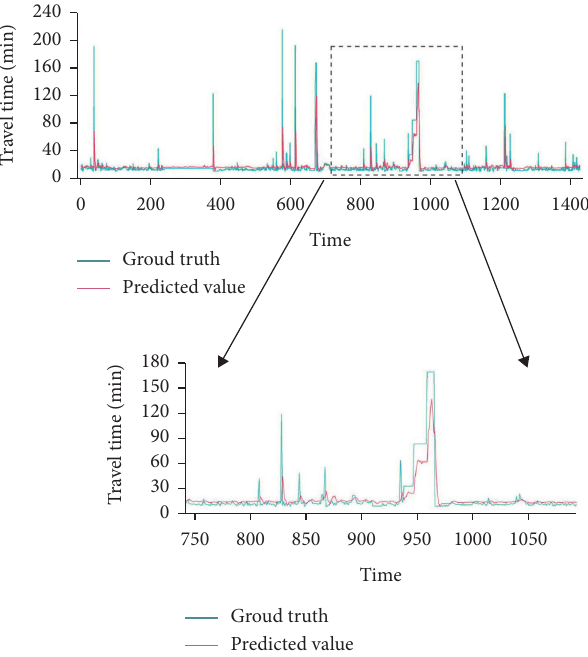
Figure 7: Prediction result of segment